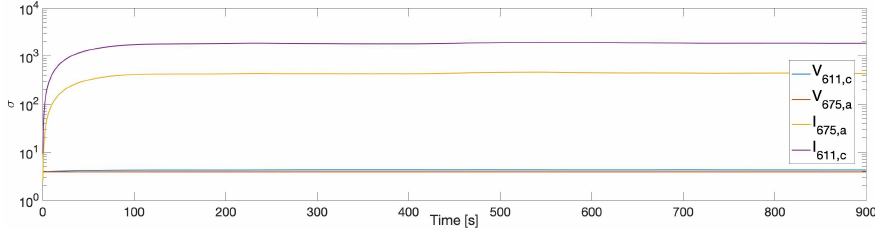
Figure 5. Variance of measurements when variance update is applied.